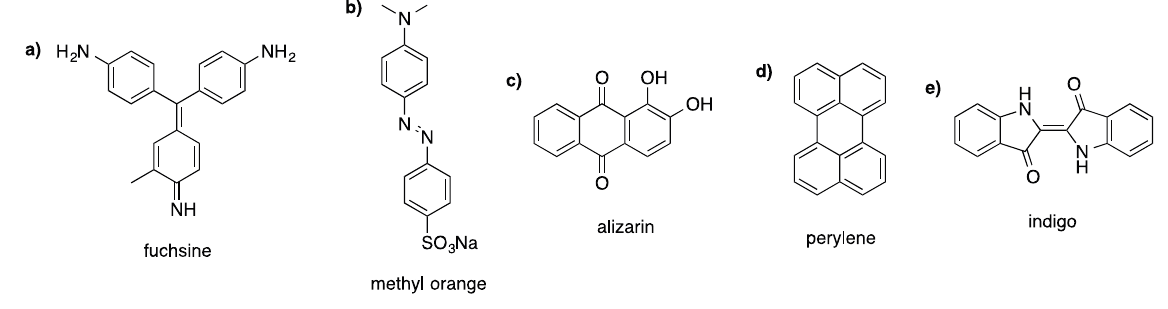
Figure 1. Characteristic representatives of ( a ) triphenylmethane dyes, ( b ) azo dyes, ( c ) anthraquinone dyes, ( d ) perylene dyes, and ( e ) indigoid